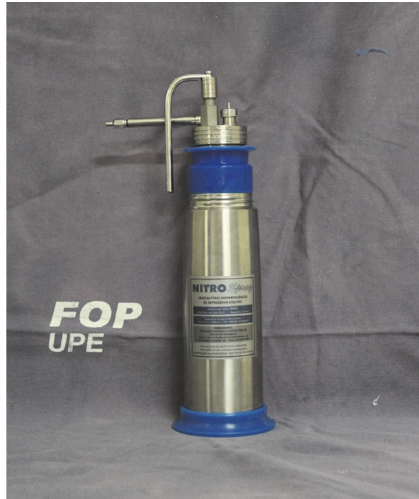
Figure 3: Cryocautery system: liquid nitrogen container and pump system used in the present case.